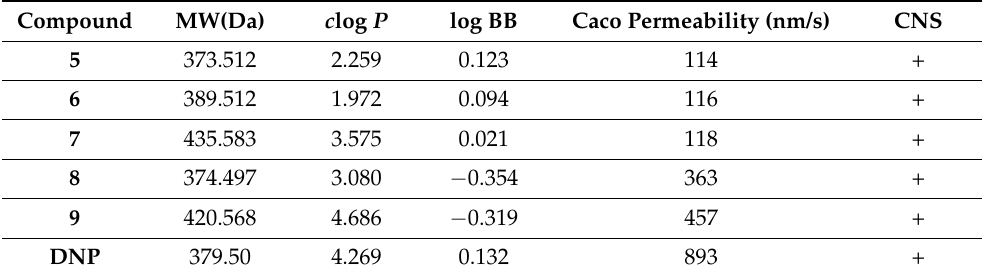
Table 1. Summary of pharmacokinetic properties predicted by the software QikProp v.2.5.